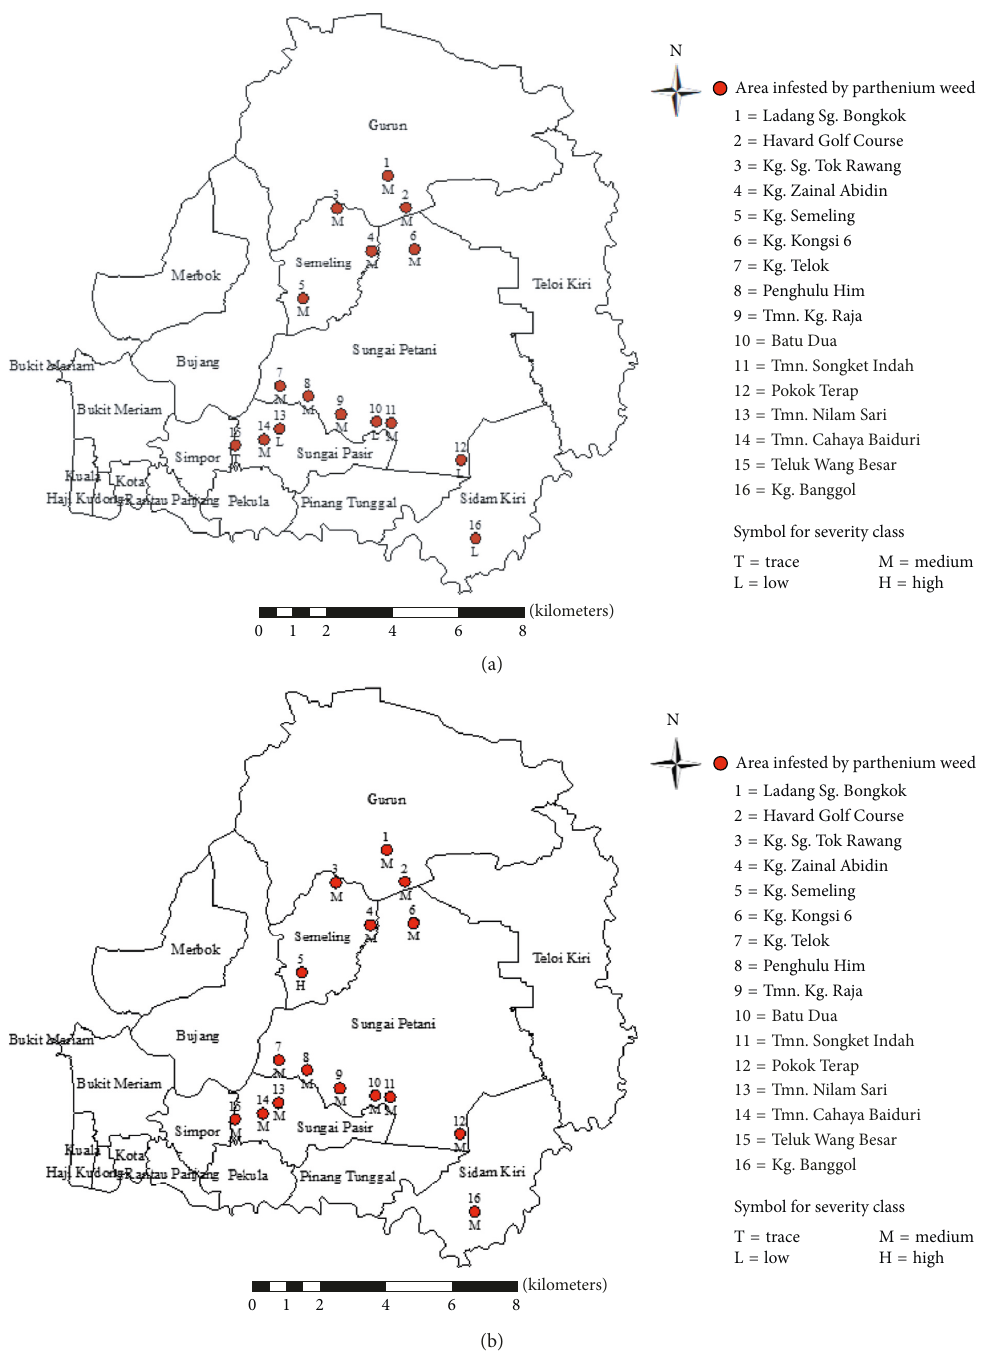
Figure 2: Map showing parthenium infestation at Kuala Muda, Kedah, in March (a) and September 2015 (b). Note that, in the second survey, the severity of infestation has changed from “L” to “M” in some locations and in one location from “M” to